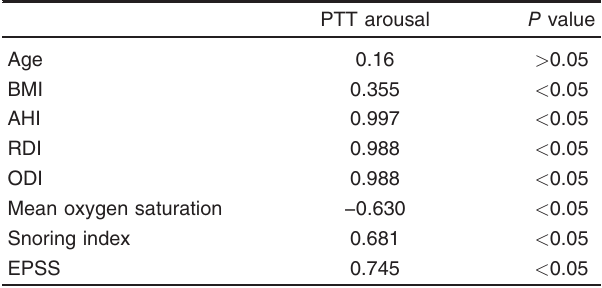
Table 2 Correlation between pulse transit time arousal and important factors